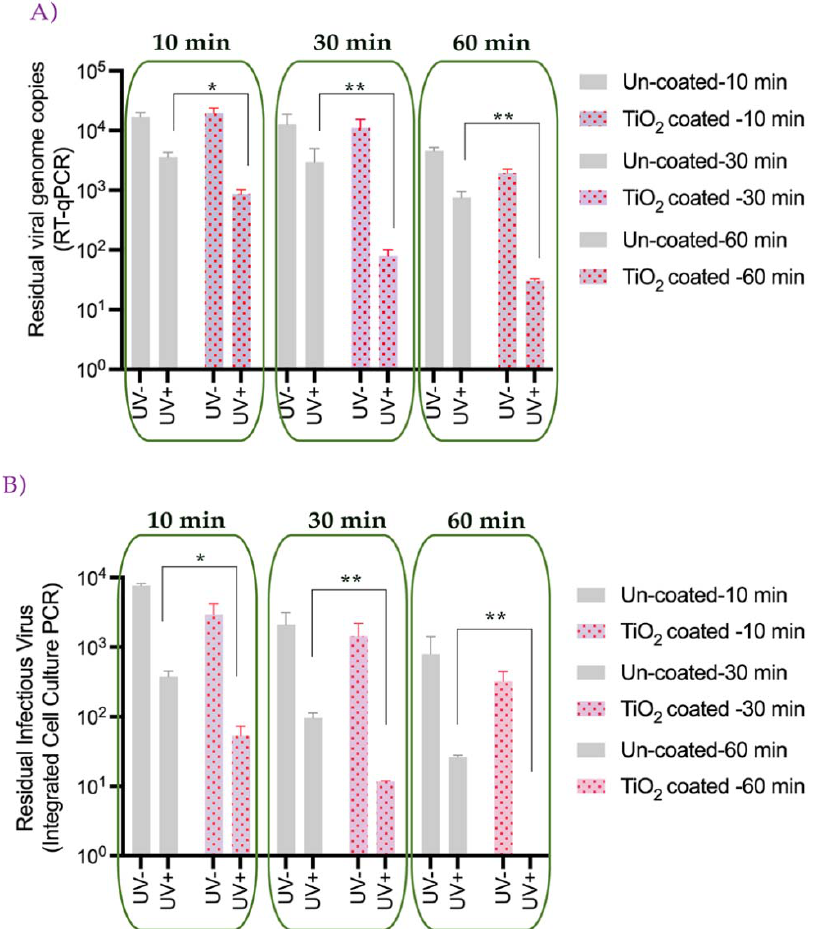
Figure 3. The effect of TiO 2 and UVA-LED irradiation on the stability of human coronavirus, HCoV- OC43. ( A ) 100 µ L of HCoV-OC43 virus was spotted on uncoated as well as TiO 2 -coated coverslips followed by exposure to UVA light for 10, 30, and 60 min. Post UV-irradiation, total viral RNA was extracted for the detection of intact viral genome copies via RT-qPCR. ( B ) 100 µ L of HCoV-OC43 virus was applied on both uncoated and TiO 2 -coated coverslips and exposed to UVA light for 10, 30, and 60 min, followed by infection of A549-hACE2 cells for 1–2 h. Post infection of A549-hACE2 cells, fresh medium was added, and the cells were incubated for 2 days. Post 48 h, total viral RNA was extracted to detect intracellular viral genome copies following infection and replication (* p < 0.1, ** p < 0.01)